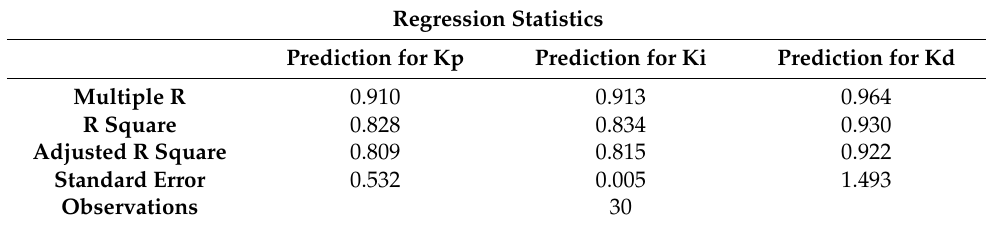
Table 4. Results of the multiple linear regression analysis.